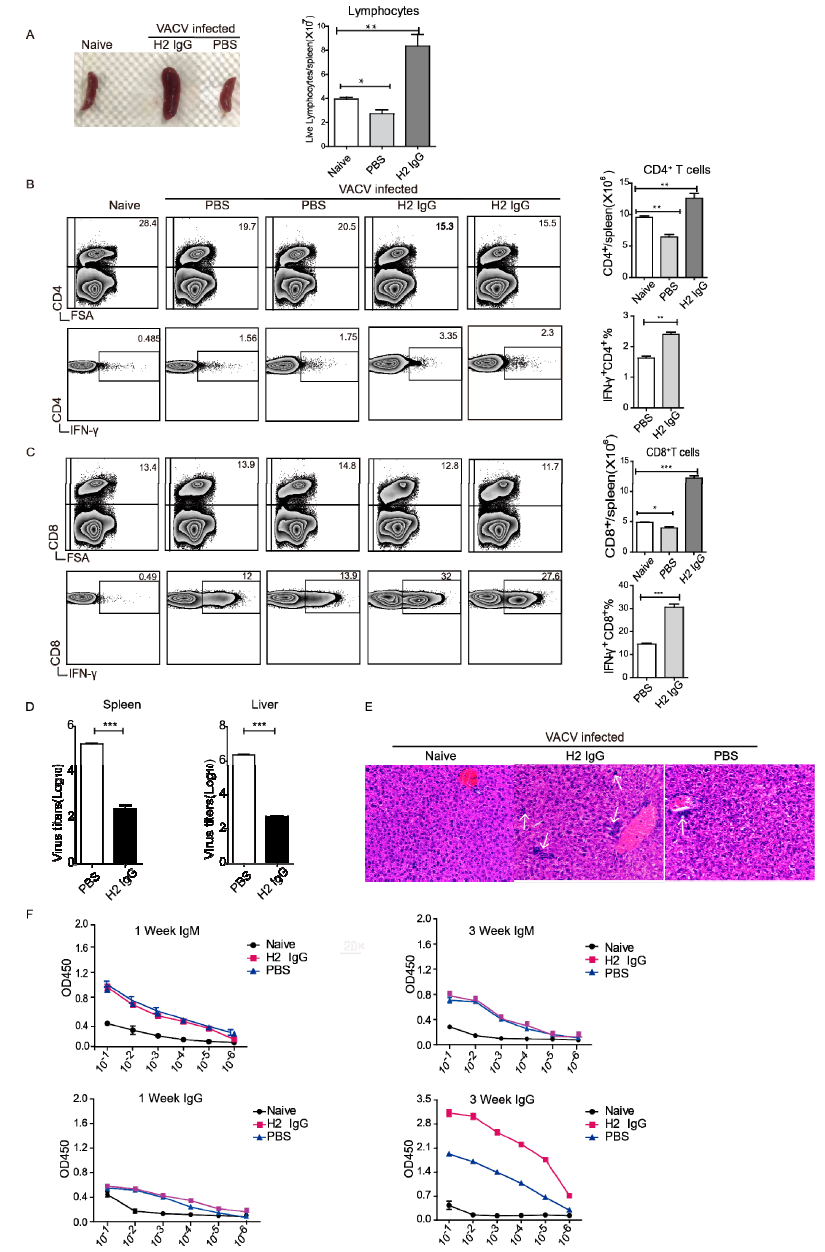
Figure 5. H2 IgG promotes anti-VACV T cell and Ab responses. ( A ) Indicated mice were administered with H2 IgG or PBS before VACV infection. The mice were euthanized at 7 dpi and the size of the spleens was observed (left panel). Total lymphocytes per spleen were counted (right panel). ( B ) Left panel: flow-cytometry analysis showing the proportion of CD4 + T cells in the spleen and the proportion of IFN- γ + cells among CD4 + T cells. FSA: forward scatter amplitude. Stained as indicated. Right panel: total CD4 + T cells per spleen and proportion of IFN- γ + cells among CD4 + T cells. ( C ) Left panel: flow-cytometry analysis showing the proportion of CD8 + T cells in the spleen and the proportion of IFN- γ + cells among CD8 + T cells. Stained as indicated. Right panel: total CD8 + T cells per spleen and proportion of IFN- γ + cells among CD8 + T cells. Numbers indicate the proportion in the nearest quadrant. ( D ) Virus titers in spleens and livers were determined at 7 dpi. ( E ) H&E stains of the liver (original magnification, × 20) at 7 dpi. The arrow pointed to the lymphocyte-infiltration area. ( F ) anti-VACV IgM or IgG Ab responses were determined at 1 week and 3 weeks pi. Data are from at least two independent experiments, with 3 mice per group in each experiment. * p < 0.05, ** p < 0.01, *** p <